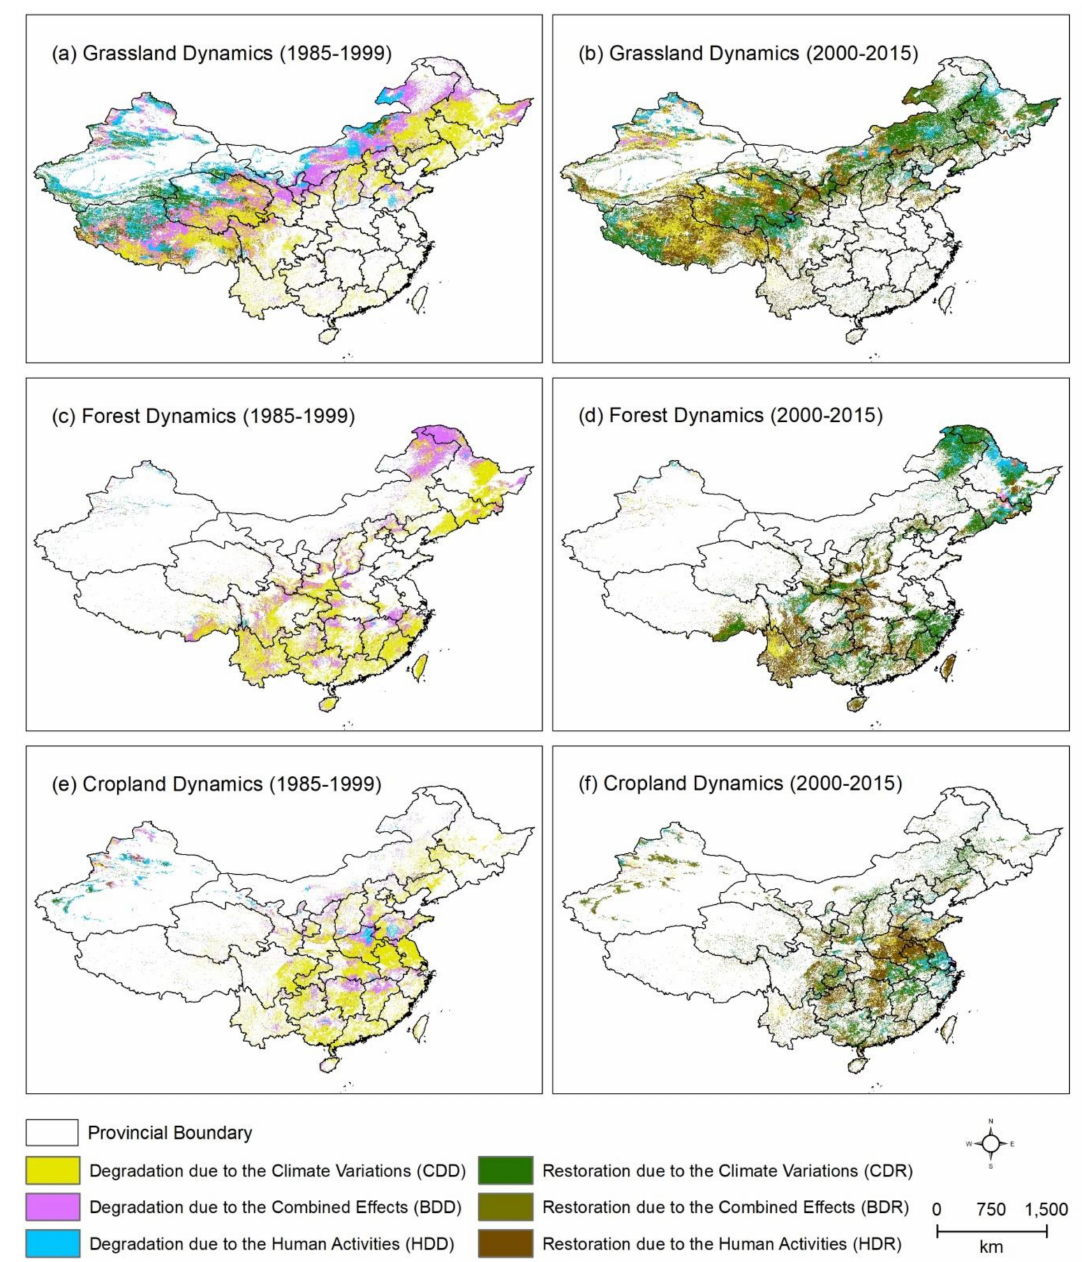
Figure 9. Spatial patterns of the relative contributions of climate variations and human activities: ( a , b ) the grassland NPP dynamics; ( c , d ) the forestland NPP dynamics; ( e , f ) the cropland NPP dynamics, under di ff erent scenarios for the base and restoration periods,